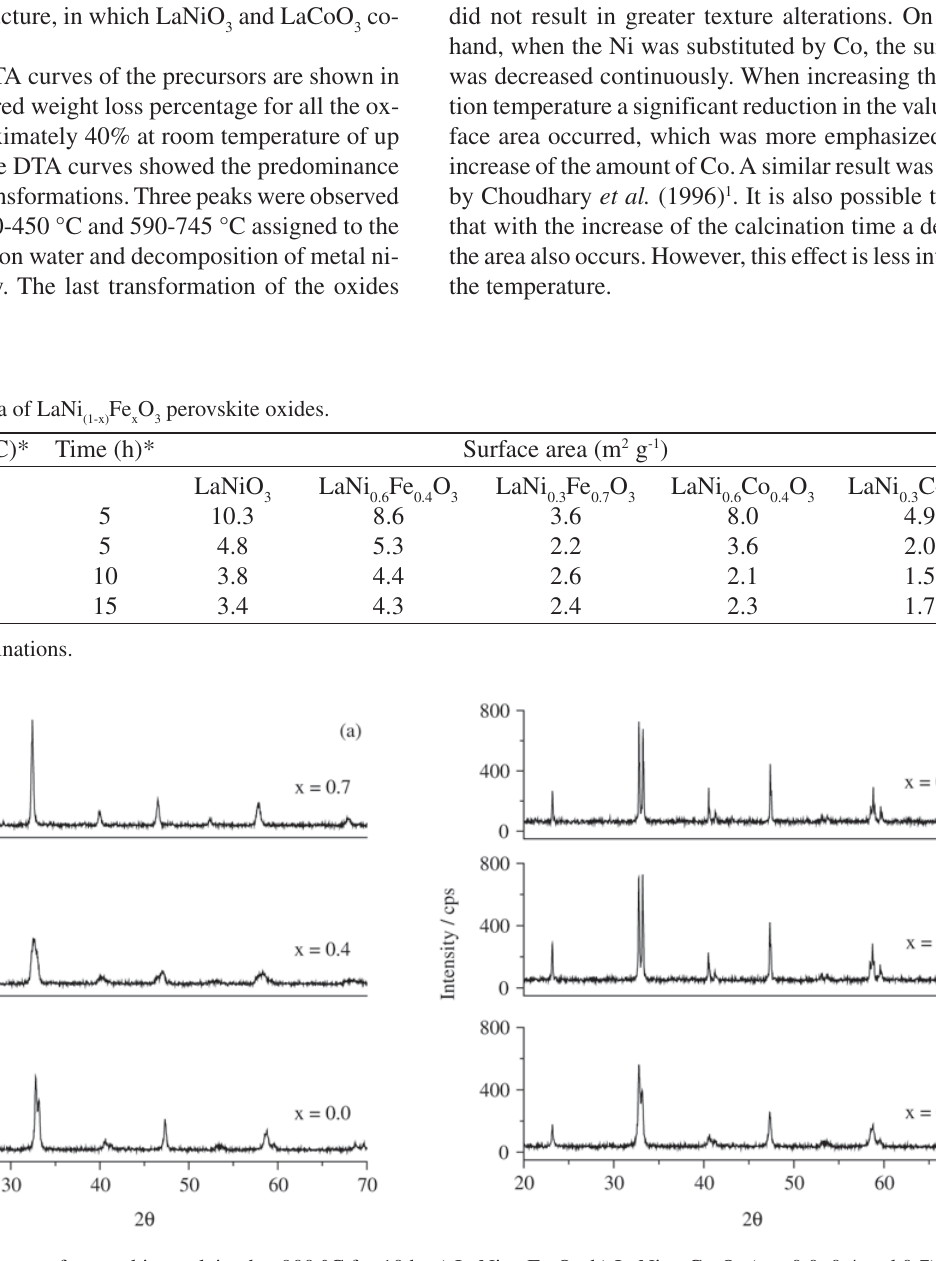
Fe O ; b) LaNi Co O (x = 0.0, 0.4 and 0.7). (1-x) x 3 (1-x) x 3